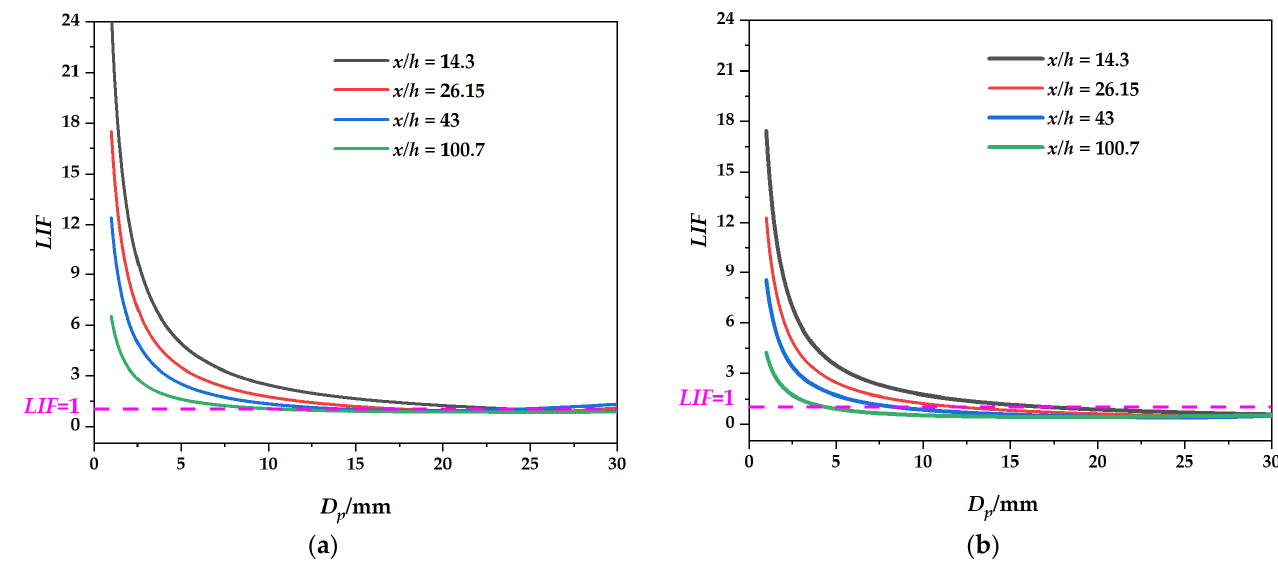
Figure 10. Lift index with different x / h over logarithmic spiral wall surfaces at ( a ) x / R = 1 and ( b ) x / R = 2/3.